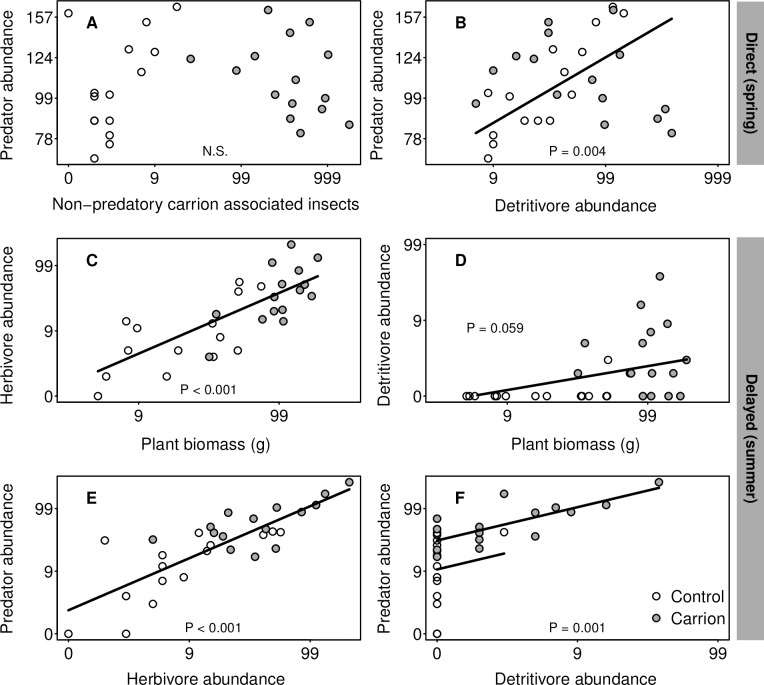
Observed relations between abundances and/or biomass of neighbouring trophic levels.The top row shows the relations in spring, the middle and bottom row show the relations in summer. Note the logarithmic scales of both axes. The relations were fitted using GLMM.